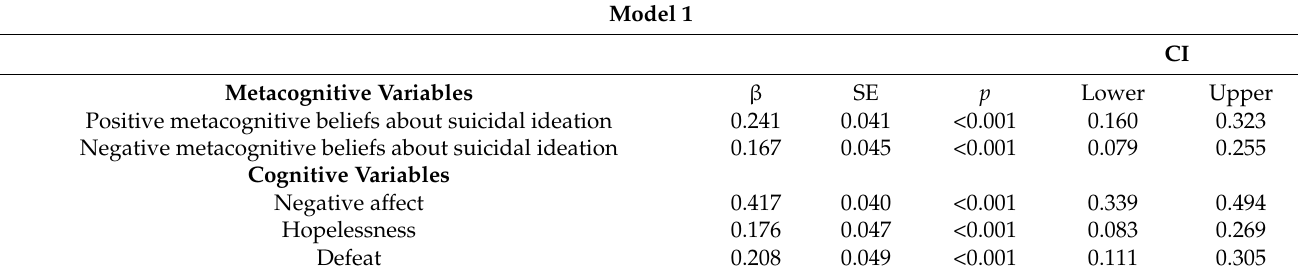
Table 5. Concurrent associations between positive and negative metacognitive beliefs about suicide and suicidal ideation (dependent variable) when all variables entered simultaneously and the effects of negative affect, hopelessness and defeat were controlled for.